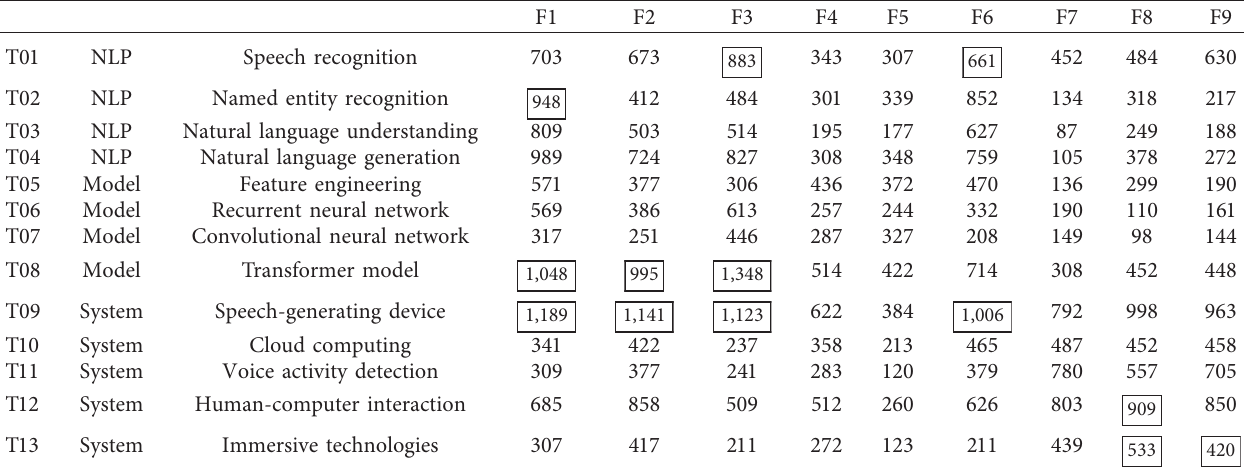
Table 12: The TFM